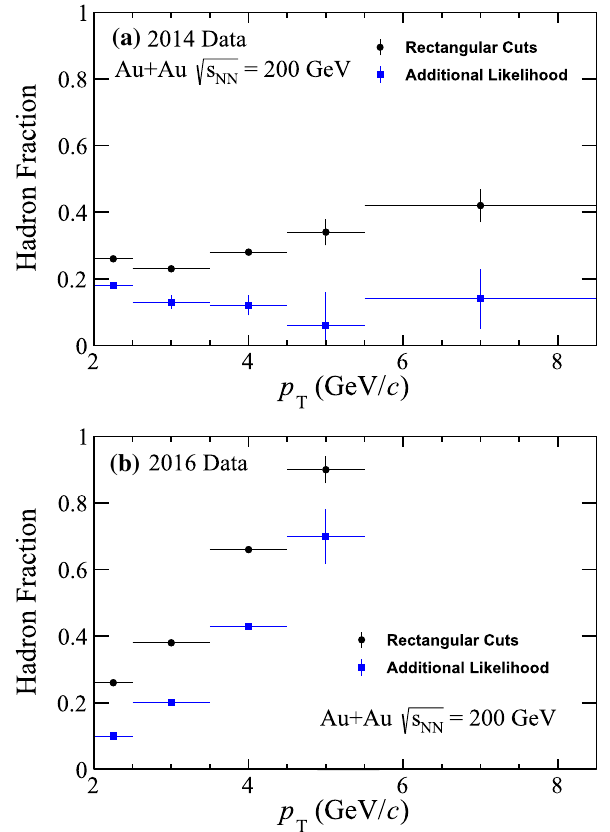
Fig. 2 Hadron contamination for rectangular particle identification (black circles) and with the additional likelihood selection (solid blue squares) in the remaining MB triggered sample described in the text for 2014 ( a ) and 2016 ( b ) data respectively